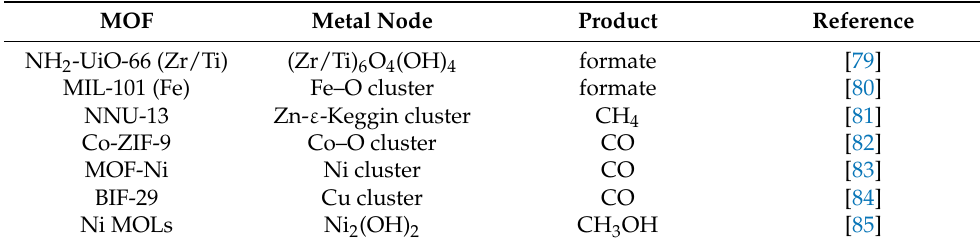
Table 2. MOFs with active metal nodes for CO 2